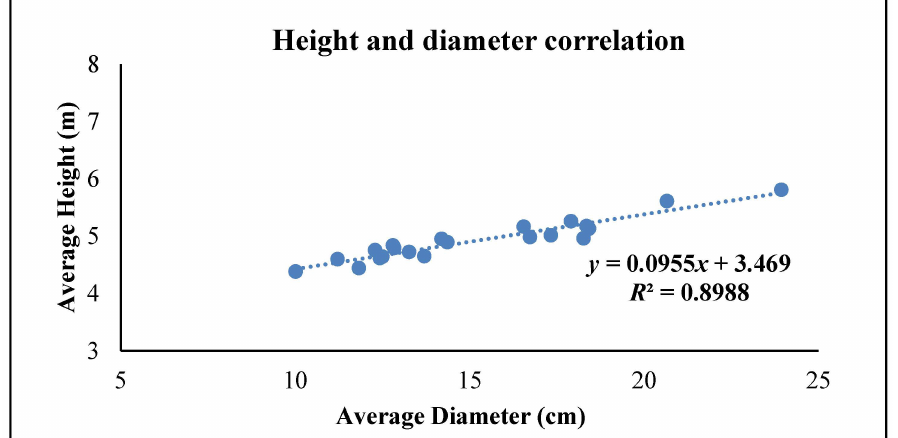
Figure 5. Correlation of average height and average diameter from the sampled plots. Table 6 shows an overall plot summary of carbon stock in above ground pool using the three equations as mentioned earlier. Plot 17 contains the highest amount of above ground biomass i.e., 22.48, 22.58 and 25.30 ton/ha, and the lowest above ground biomass is found in plot 21 i.e., 2.37, 1.99, and 2.01 ton/ha. The overall average living biomass of the forest of all plots using the three equations is 8.34, 7.79 and 8.4 ton/ha,